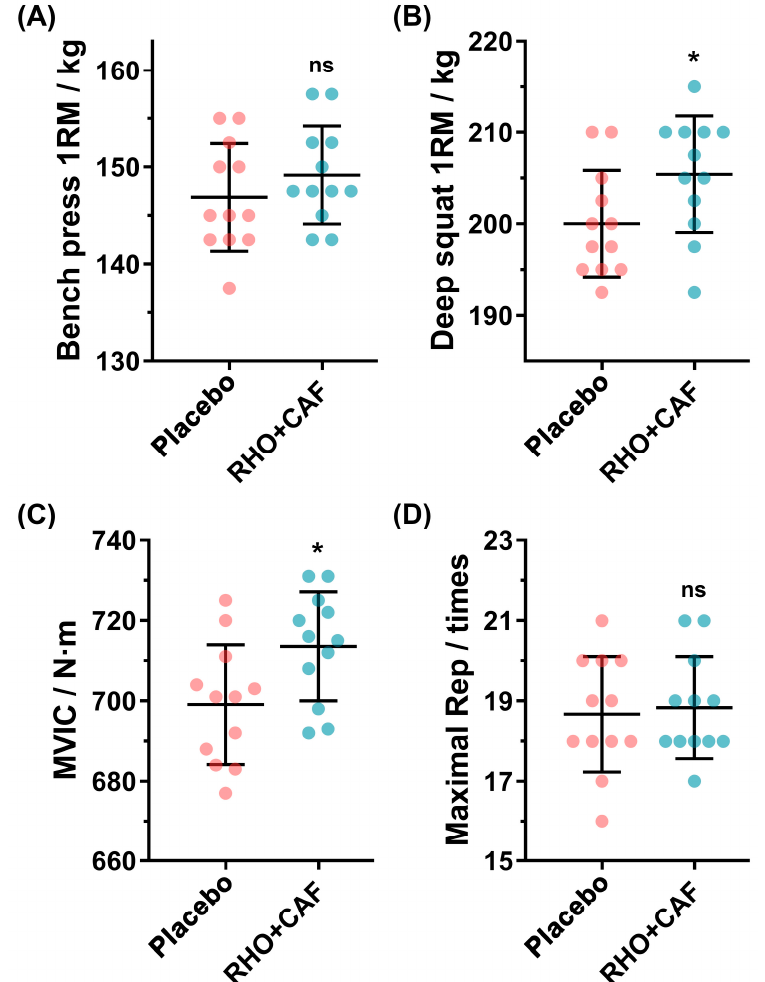
Figure 5. Improvements following supplement treatment for resistance exercise-trained volunteers. ( A ) Bench press 1RM. ( B ) Deep squat 1RM. ( C ) MVIC. ( D ) Maximal repetitions of 60% 1RM bench press. All data are presented as mean ± SD (n = 12 × 2 groups = 24 samples). ns indicates no statistical difference and * indicates p < 0.05 between the compared groups.